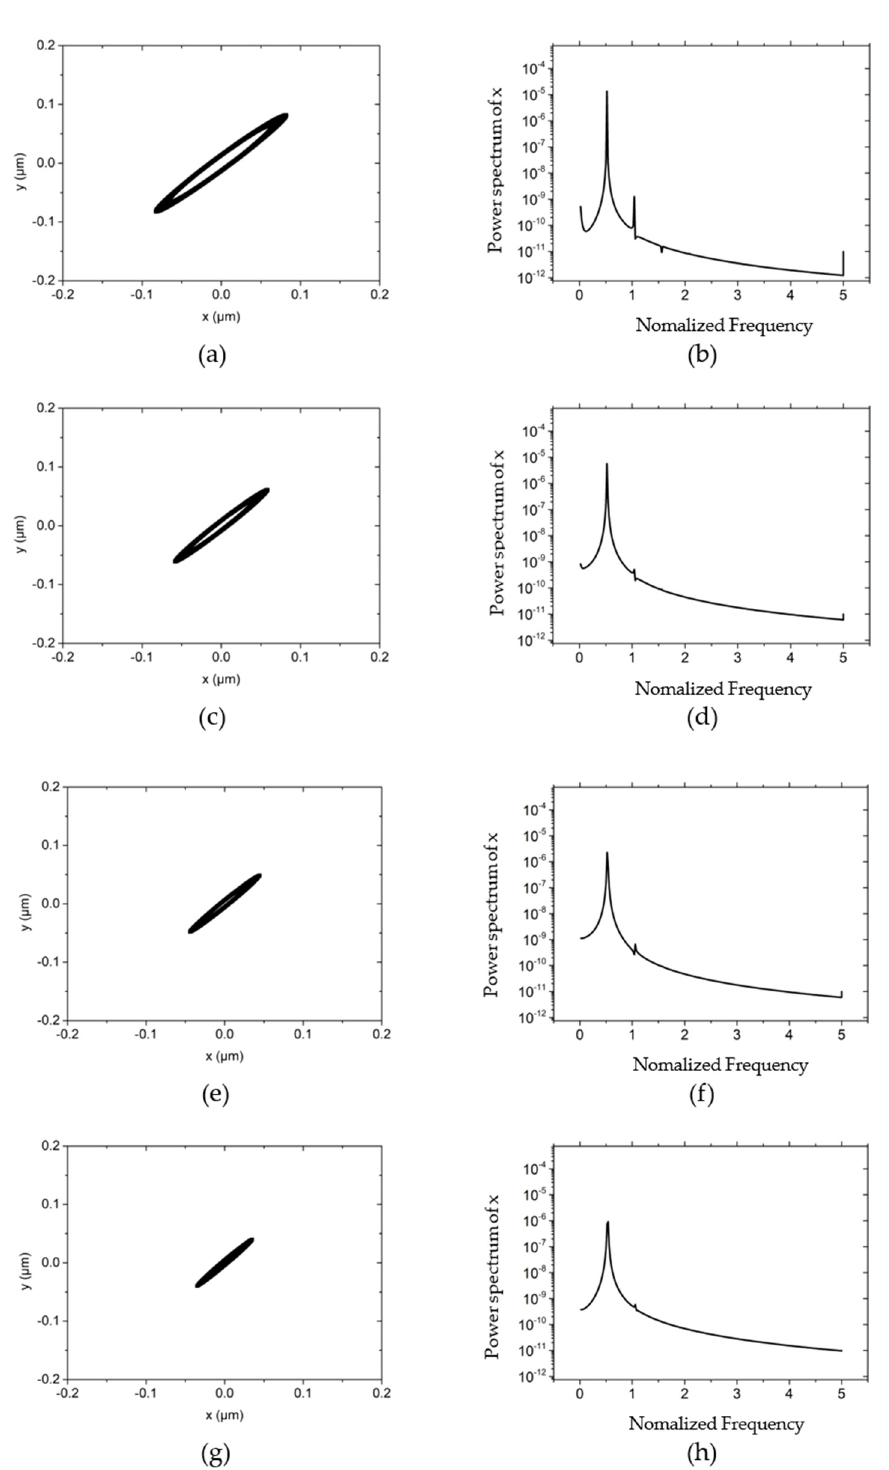
Figure 6. The influence of different rotor mass on rotor trajectory and power spectral density at w = 50,000 r/min, m u = 0.01 g, m = 90 g. ( a ) Rotor center trajectory ( Fy = 20 N), ( b ) Power spectral density in the x direction ( Fy = 20 N), ( c ) Rotor center trajectory ( Fy = 30N), ( d ) Power spectral density in the x direction ( Fy = 30 N), ( e ) Rotor center trajectory ( Fy = 40 N), ( f ) Power spectral density in the x direction ( Fy = 40 N), ( g ) Rotor center trajectory ( Fy = 50 N), ( h ) Power spectral density in the x direction ( Fy = 50 N).